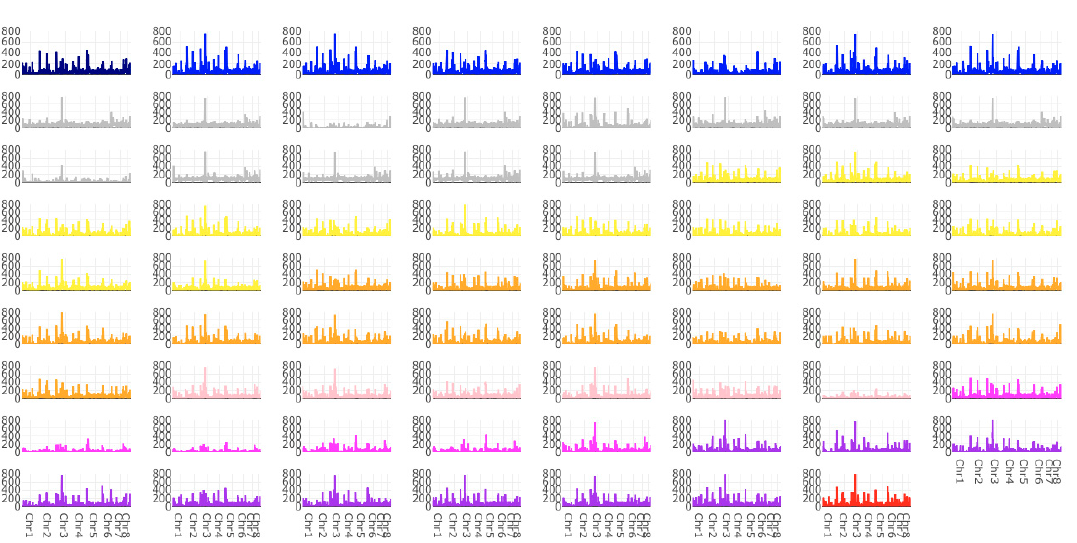
Figure 1. Single nucleotide polymorphism (SNP) density plots across eight chromosomes representing the number of SNPs within 20 kb window size. The color indicates the strain’s AMB MIC value: 0.06 (navy), 0.125 (blue), 0.1875 (grey), 0.25 (yellow), 0.5 (orange), 1 (light pink), 2 (pink), 4 (purple) and 8 (red) mg/L.